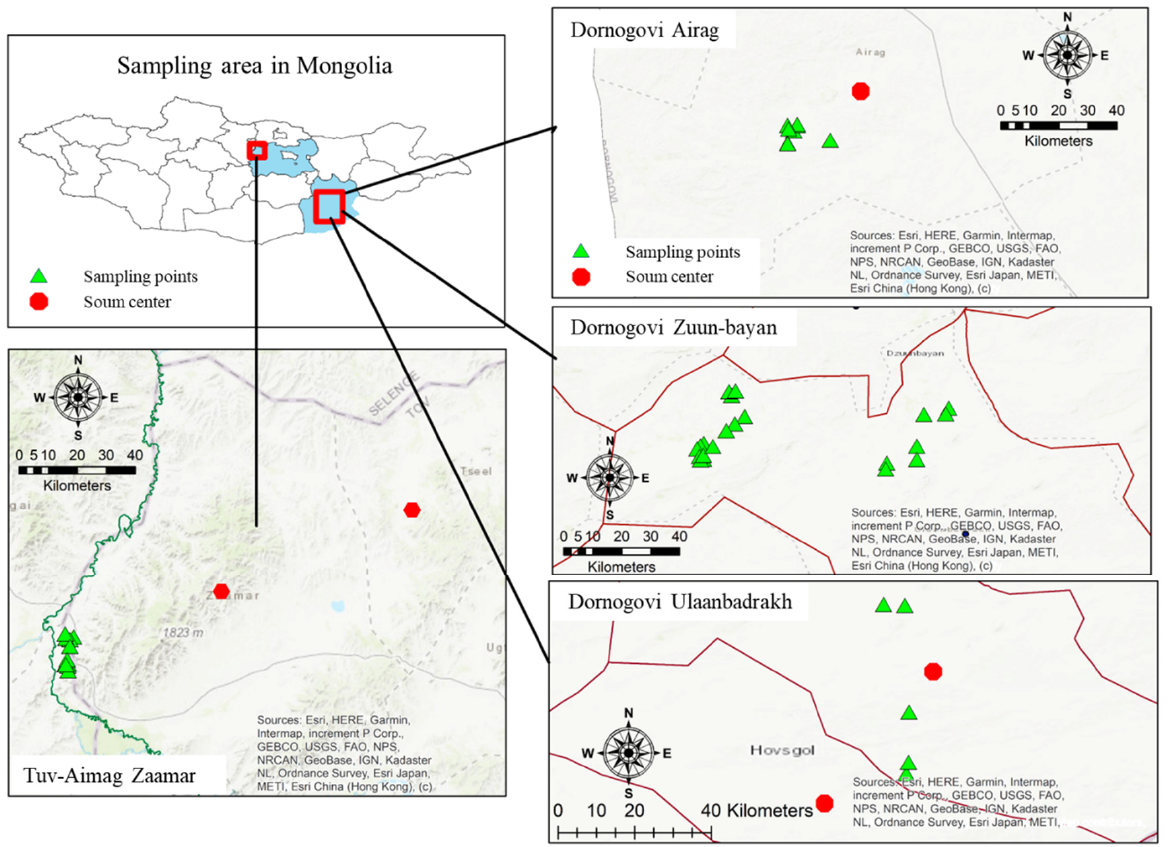
Figure 1. Sampling location. Sampling areas in Tuv-Aimag Zaamar, Dornogovi Airag, Zuun-bayan and Ulaanbadrakh were described by map using ArcGIS 10.7.1 (ESRI Co., Redlands, CA, USA).